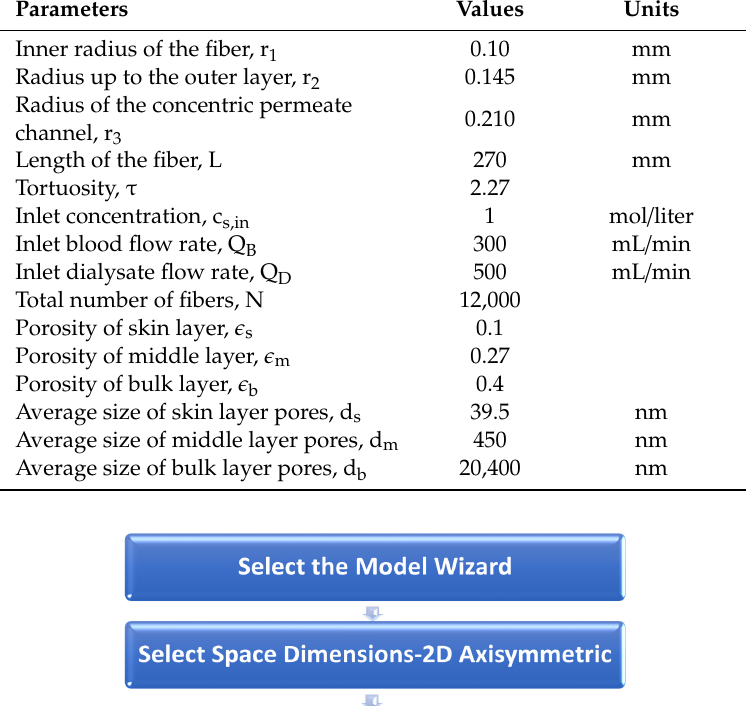
Table 2. A comprehensive dataset of model parameters used for model predictions [17,22].